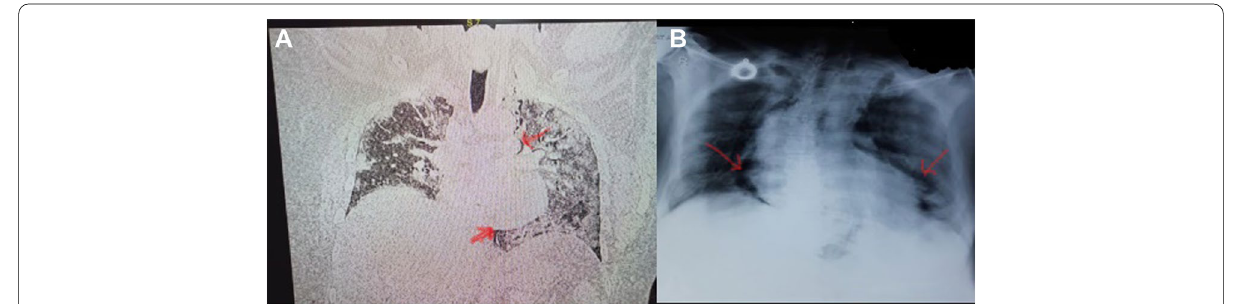
Fig. 2 A HRCT on admission. B CXR showing pneumomediastinum (red